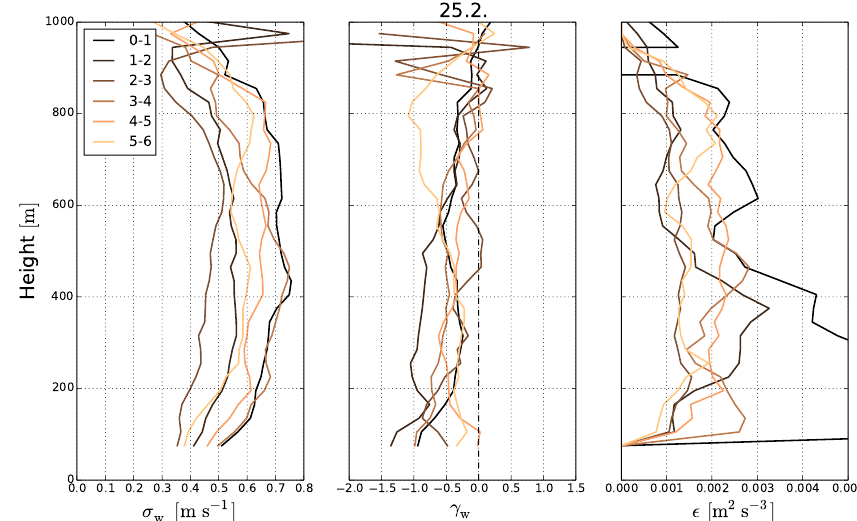
Figure 7. Profiles of the standard deviation ( σ w ) and skewness ( γ w of vertical velocity and the dissipation rate ( (cid:15) ) for 1h segments during the early hours of 25